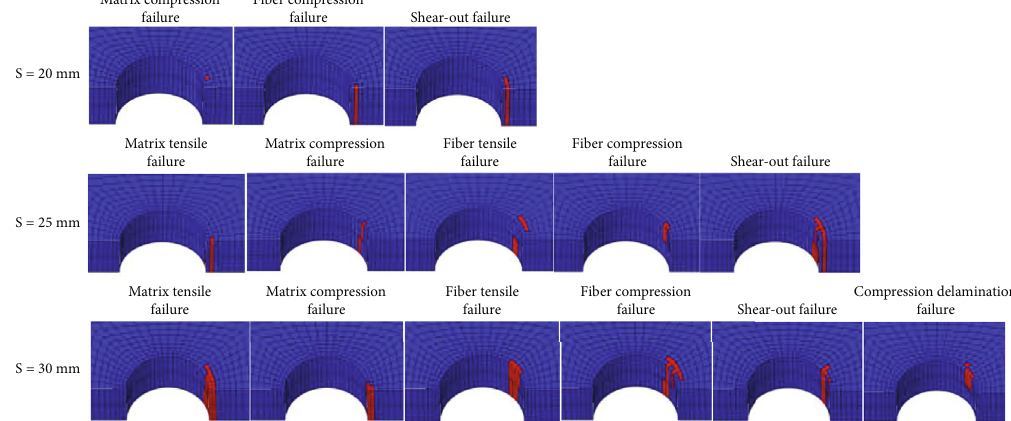
Figure 15: Damage failure patterns around the inner fastener hole of ceramic matrix plate of the double bolted joints with various values of double-bolt center spacing at 750 °